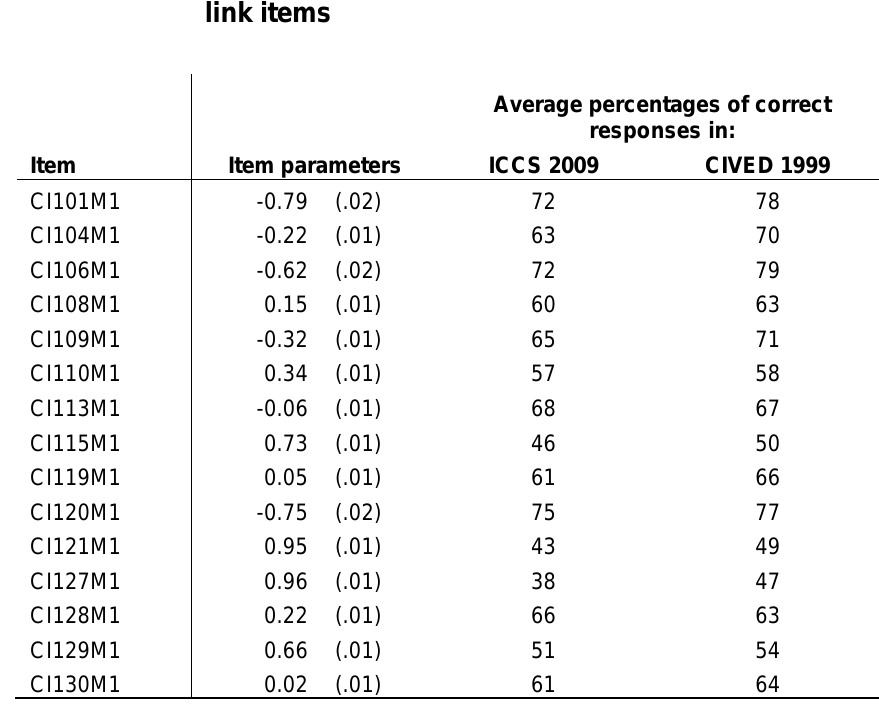
Table 1 Item parameters and average percent correct for link items